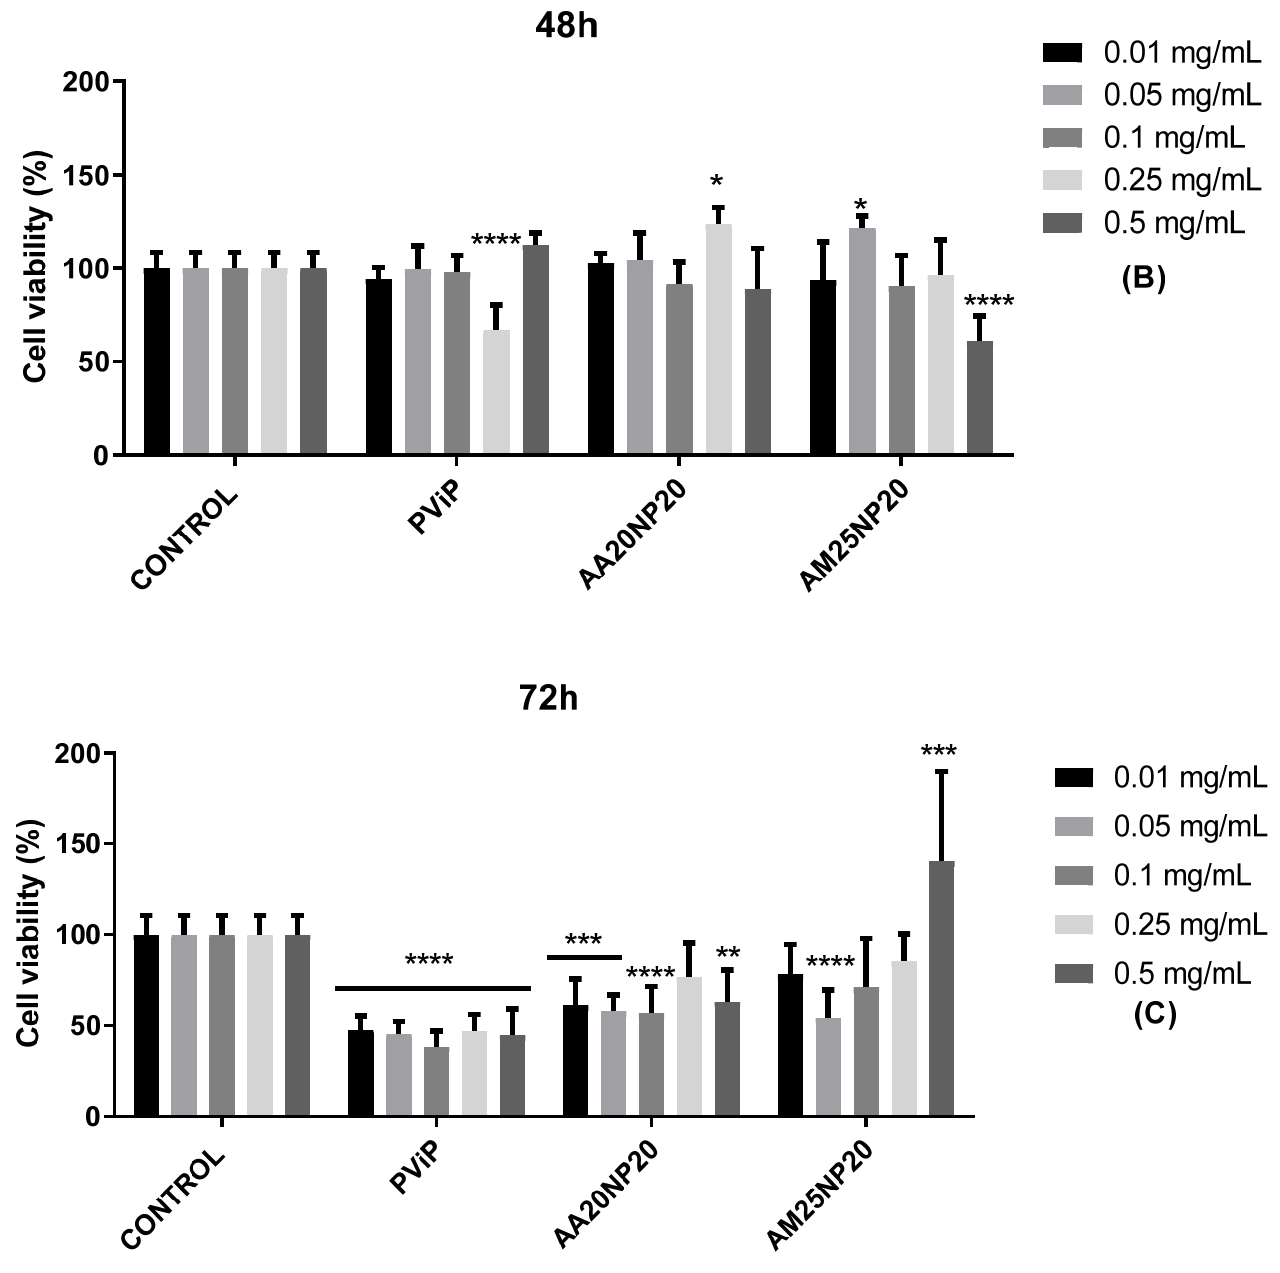
Figure 8. Evaluation of the cytotoxic activity of the polymer samples on human keratinocyte (HaCaT) cells after ( A ) 24, ( B ) 48, and ( C ) 72 h exposure at the particle concentrations of 0.01, 0.05, 0.1, 0.25, and 0.5 mg/mL. Asterisks are related to different confidence intervals associated with statistical significance: * 95% with p ≤ 0.05, ** 99% with p ≤ 0.01, *** 99.9% with p ≤ 0.001, and **** 99.99% with p ≤ 0.0001.